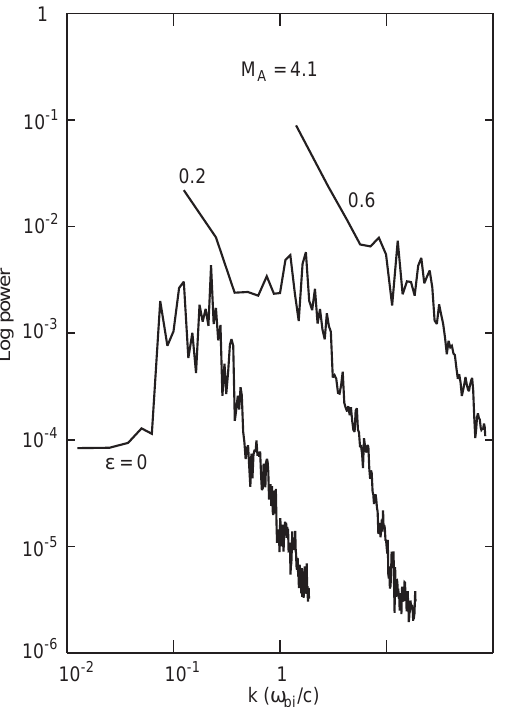
Fig. 3. Power spectra of the magnetic field fluctuations upstream of a M A (cid:136) 4 : 1 shock at X cp t (cid:136) 600 for di(cid:128)erent upstream imposed turbulence levels ( (cid:15) (cid:136) 0 ; 0 : 2 ; and 0.6). The spectra are o(cid:128)set by a